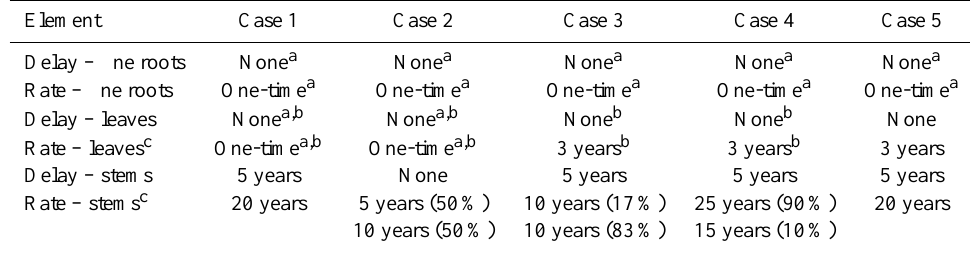
Table 2. Parameters for the dynamics of dead standing trees (DSTs) currently represented in MIM. Element Case 1 Case 2 Case 3 Case 4 Case 5 Delay – fine roots None a None a None a None a None a Rate – fine roots One-time a One-time a One-time a One-time a One-time a Delay – leaves None a,b None a,b None b None b Rate – leaves c One-time a,b